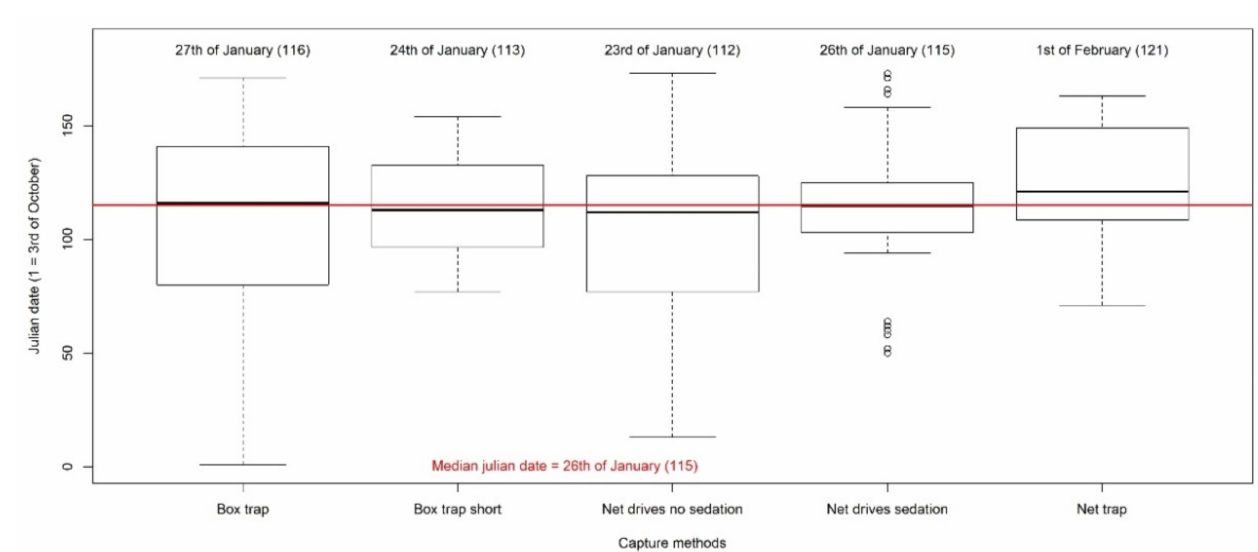
Figure A1. Date of capture and release for the five capture methods.